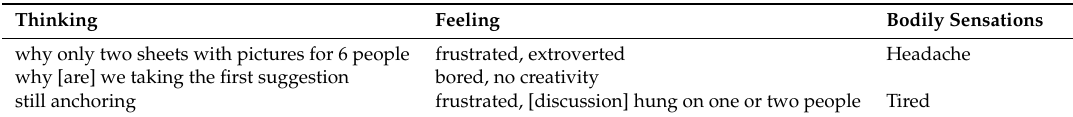
Table 5. Participant 11’s micro